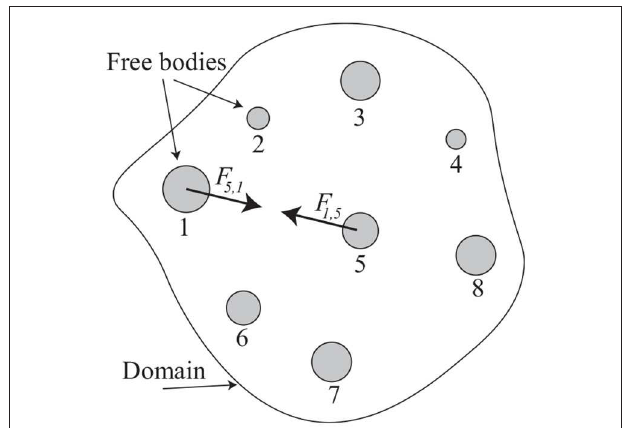
FIGURE 1 | System with eight free